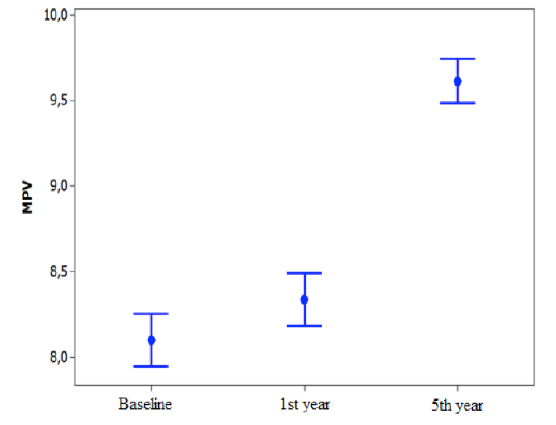
Figure 1B: Mean platelet volume (MPV) at baseline and at the first and fifth years of hormone therapy in the study